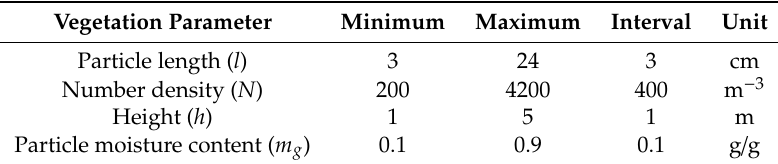
Table 1. Vegetation parameters used in the GRG-based model simulation. Vegetation Parameter Minimum Maximum